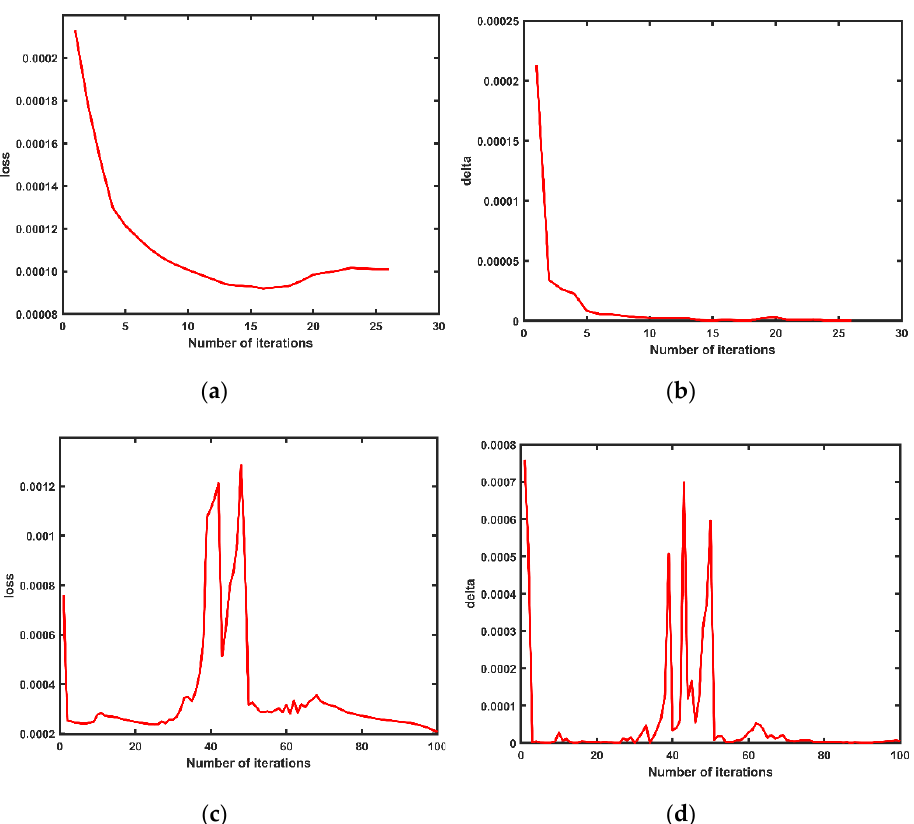
Figure 13. Two variations of error parameters in the point cloud matching process. ( a ) The loss changed during the matching of the main view with the point cloud from view1 ; ( b ) the delta changed during the matching of the main view with the point cloud from view1 ; ( c ) the loss changed during the matching of the main view with the point cloud from view2 ; ( d ) the delta changed during the matching of the main view with the point cloud from view2.